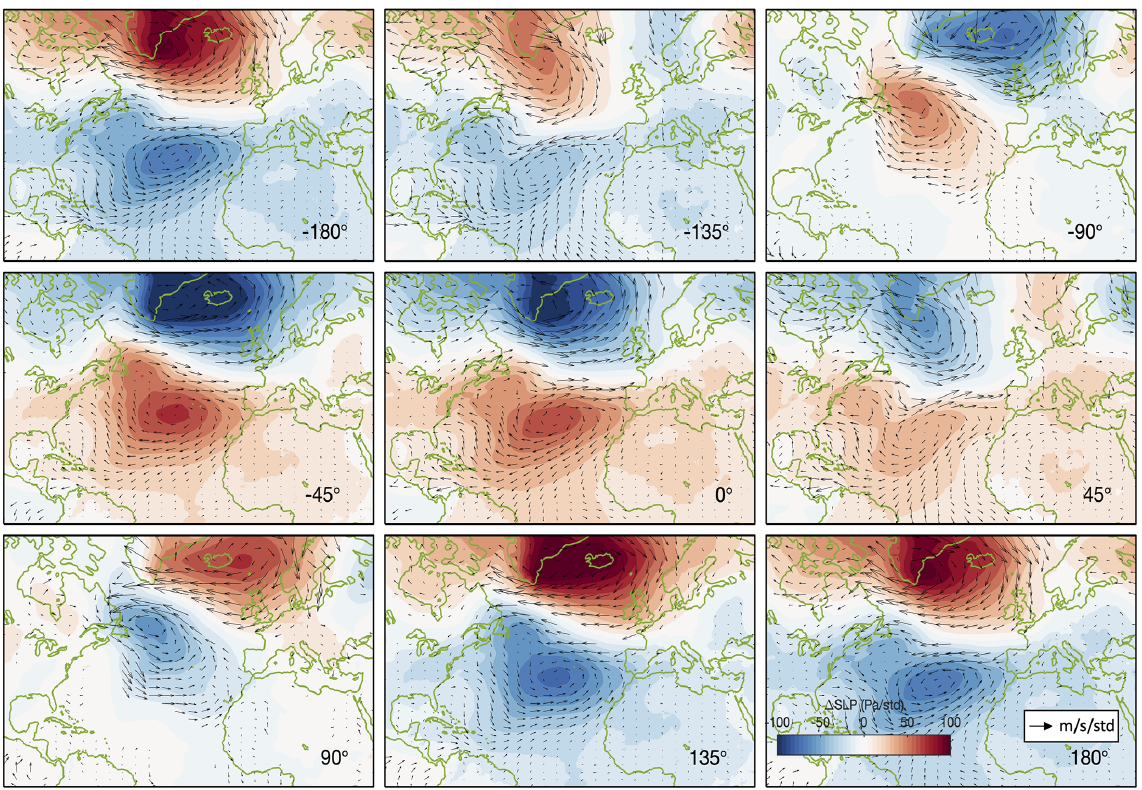
Figure 11. Regression maps of (color) sea level pressure (SLP) and (arrows) 10m wind velocity on CPC 1 rotated every 45 ◦ at ± 180 ◦ showing the full-cycle evolution of wind forcing patterns associated with the CEOF 1 mode of the low-pass-filtered SSH. Arrows are plotted only at locations where regression coefficients are significant at 95%